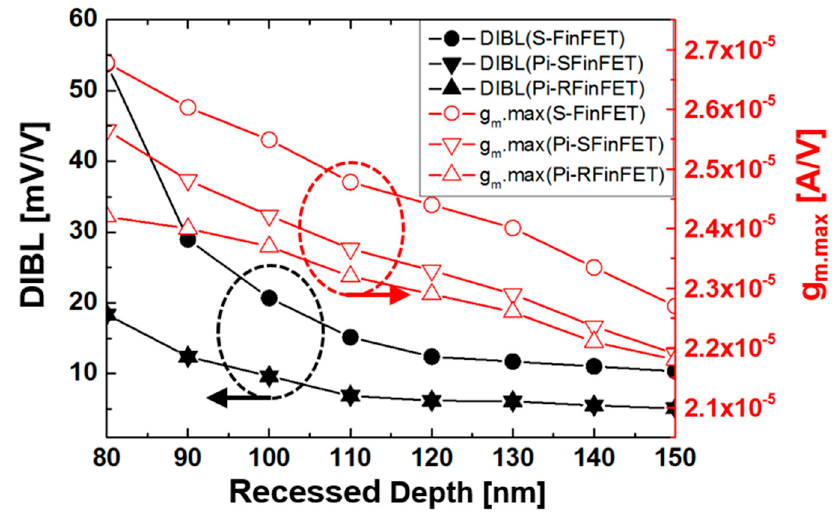
Figure 6. DIBL (V DS.low = 0.05 V, V DS.high = 1.5 V) and g m.max characteristics of Pi-FinFETs and S-FinFET according to the recessed depth when L g is 30 nm.